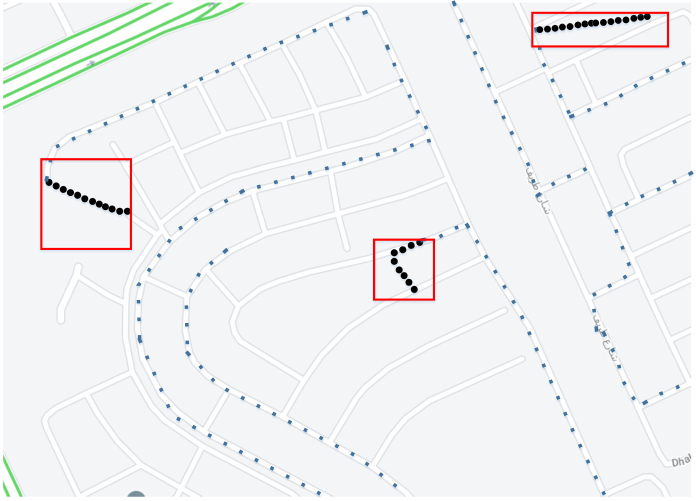
Figure 6. An example of unmatched